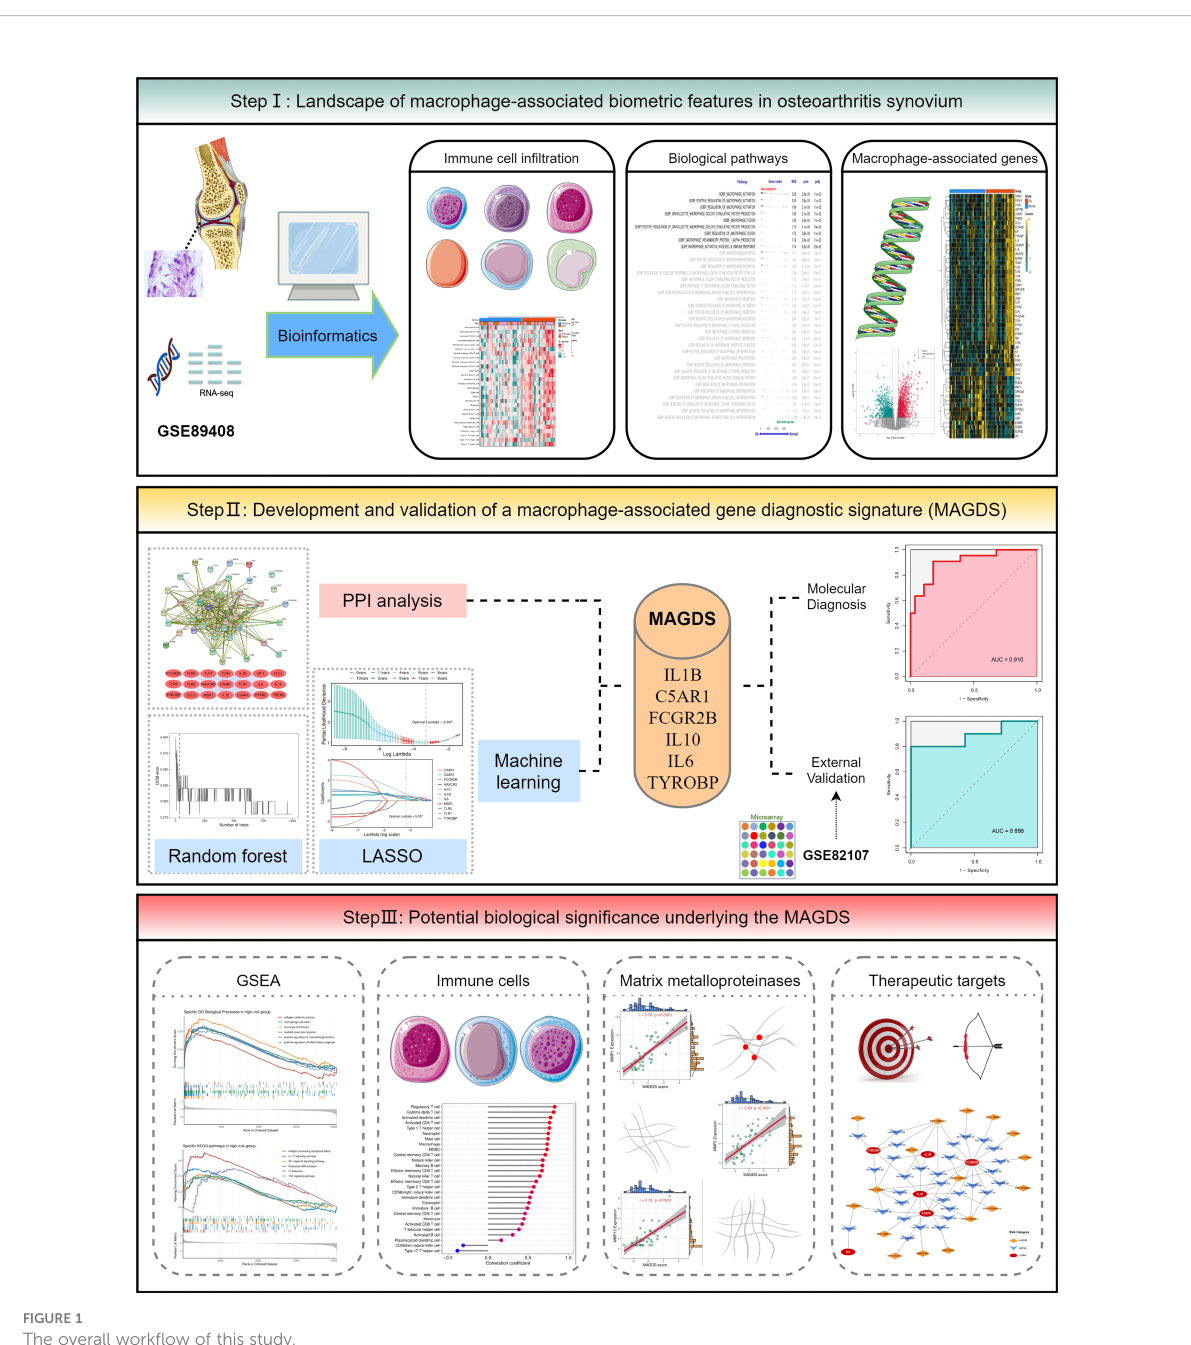
FIGURE 1 The overall work fl ow of this